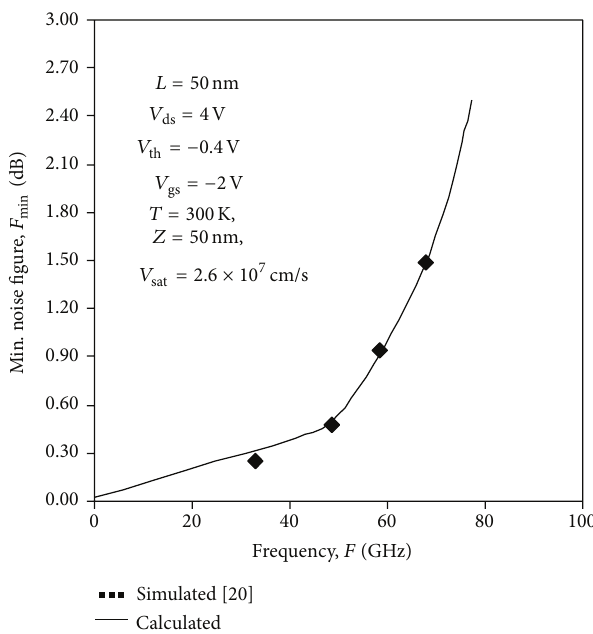
Figure 15: Dependence of minimum noise figure on frequency.